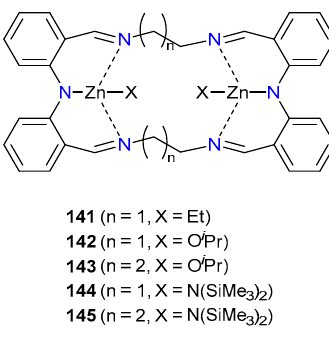
Figure 26. Dizinc(II) complexes of macrocycle Schiff-base ligands [83,84].